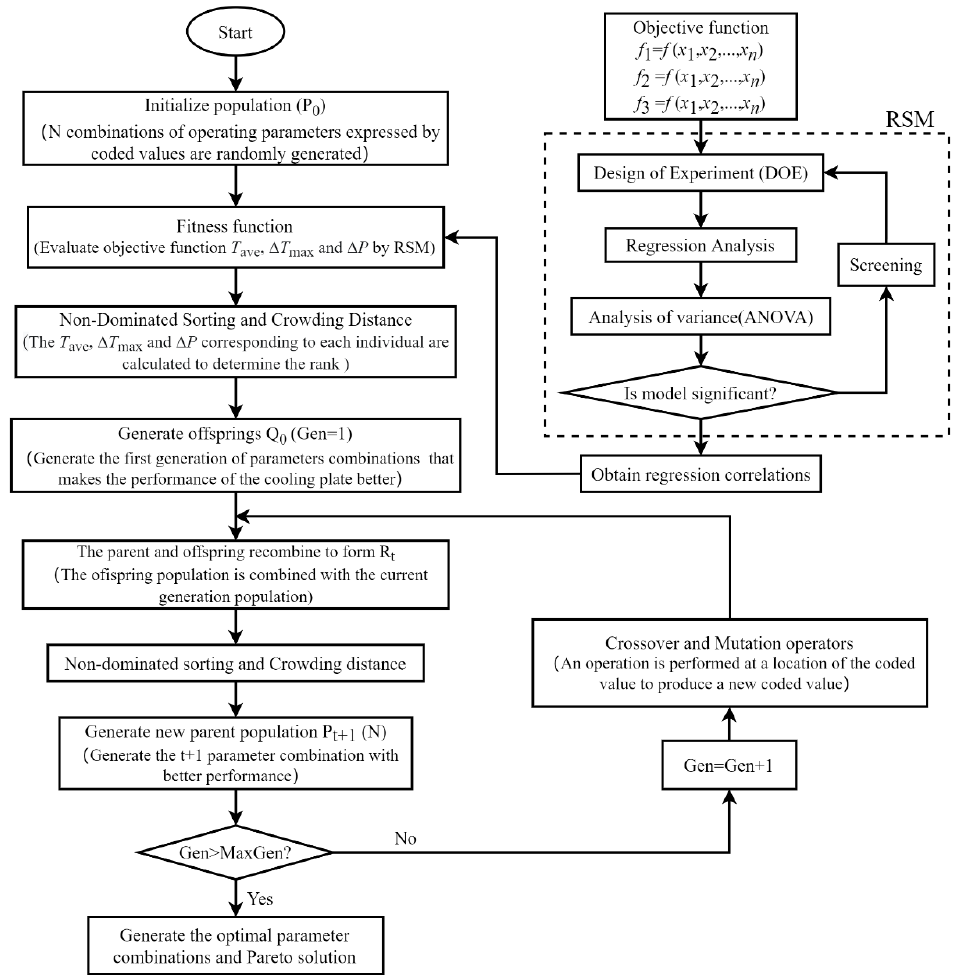
Figure 6. The flowchart of the optimization procedure.